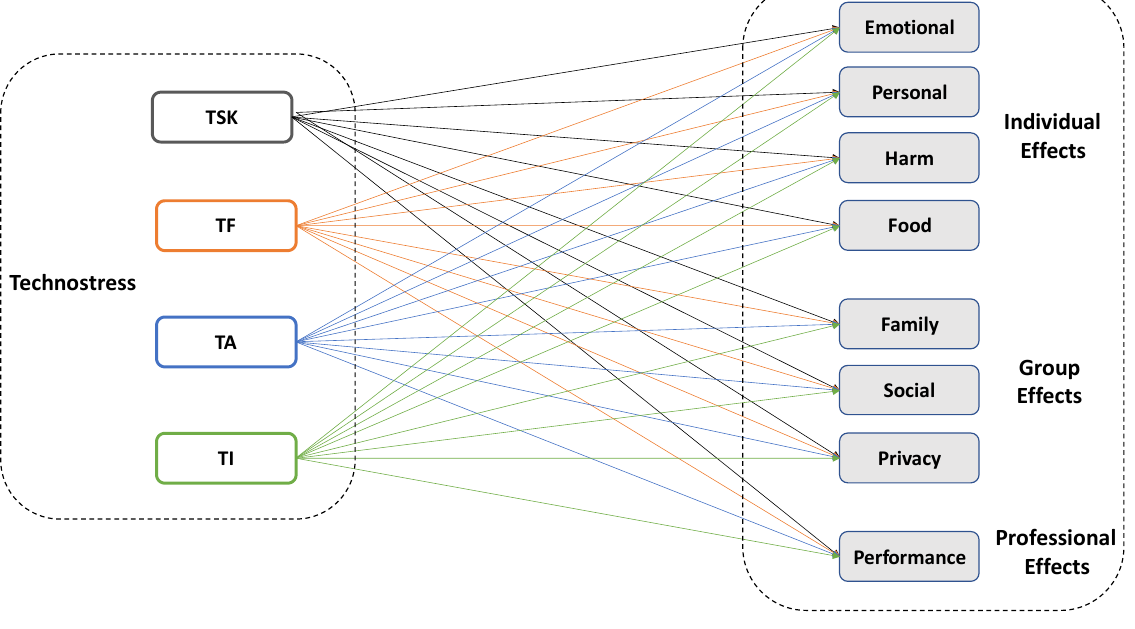
Table 5. Sample composition by archetypes.